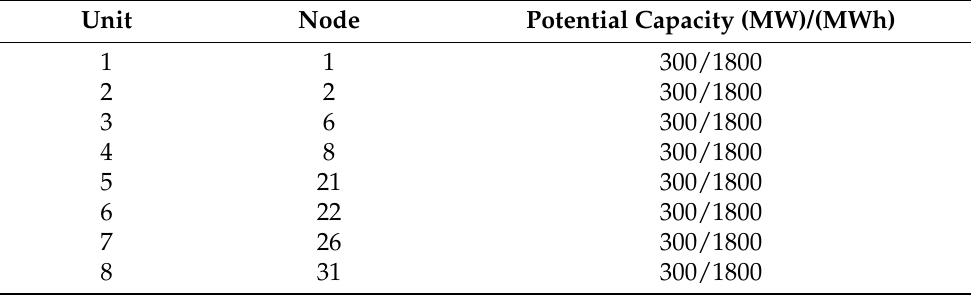
Table 3. Technical characteristics of candidate storage